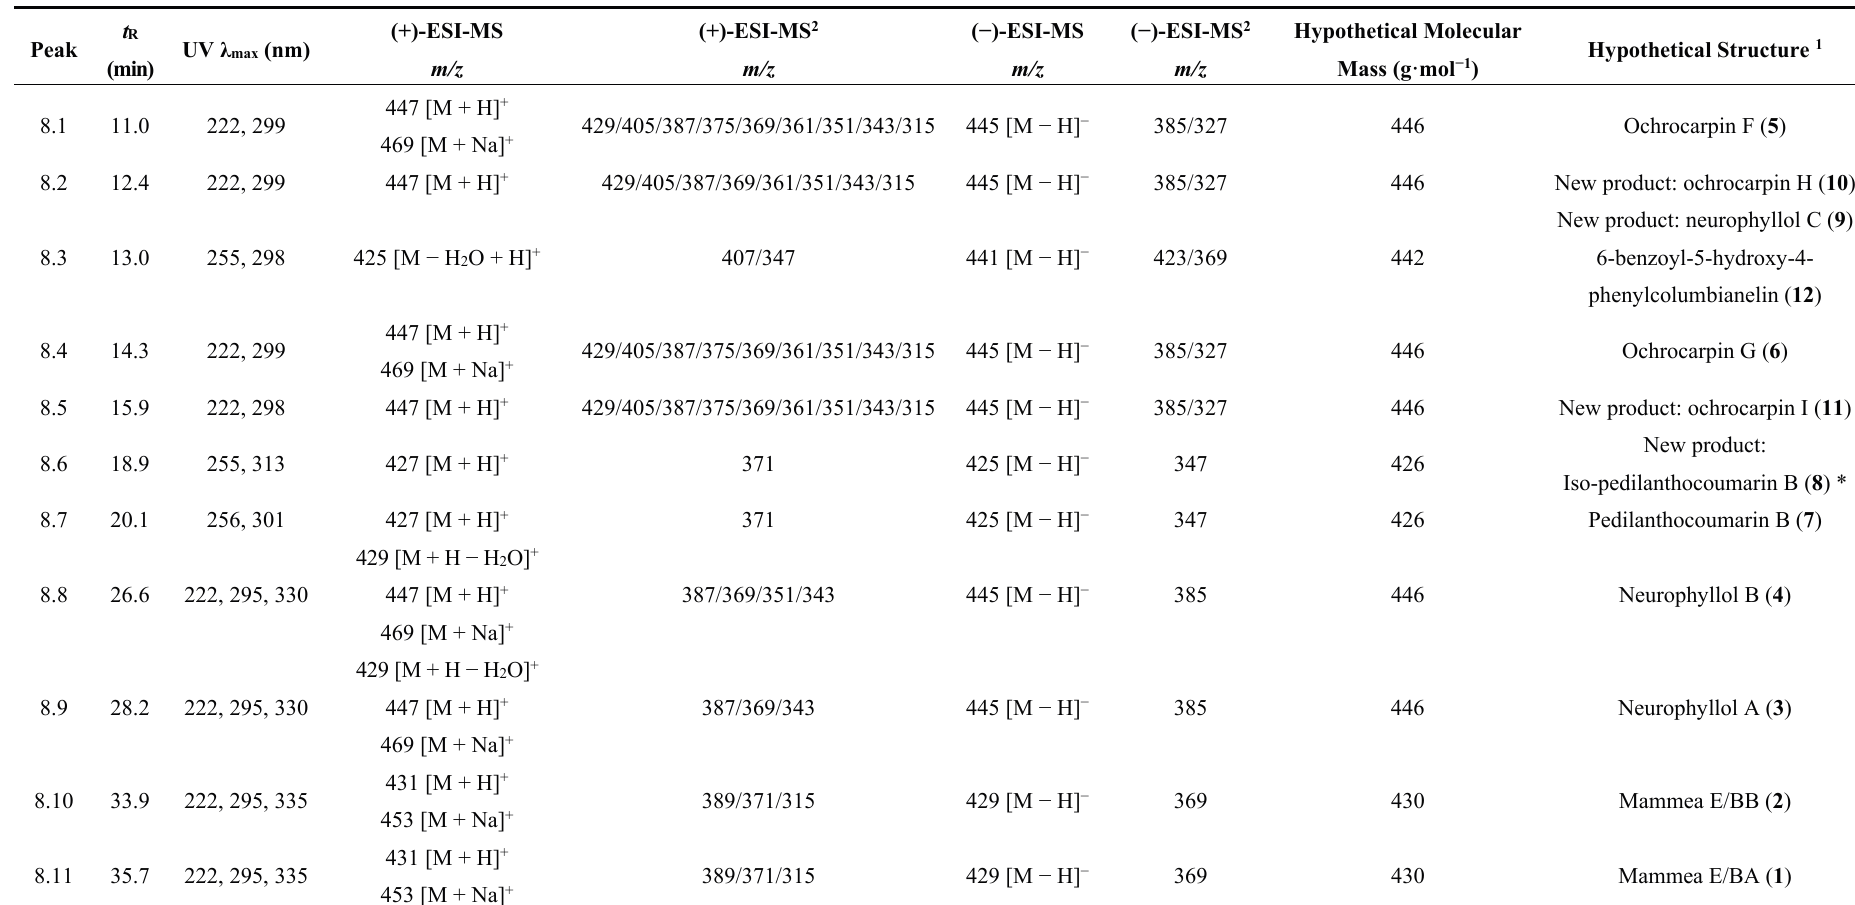
Table 1. Retention time, ( t R ), UV spectrum, HRMS and ESI-MS n data for peaks identified in Fraction VIII from dichloromethane (DCM) bark